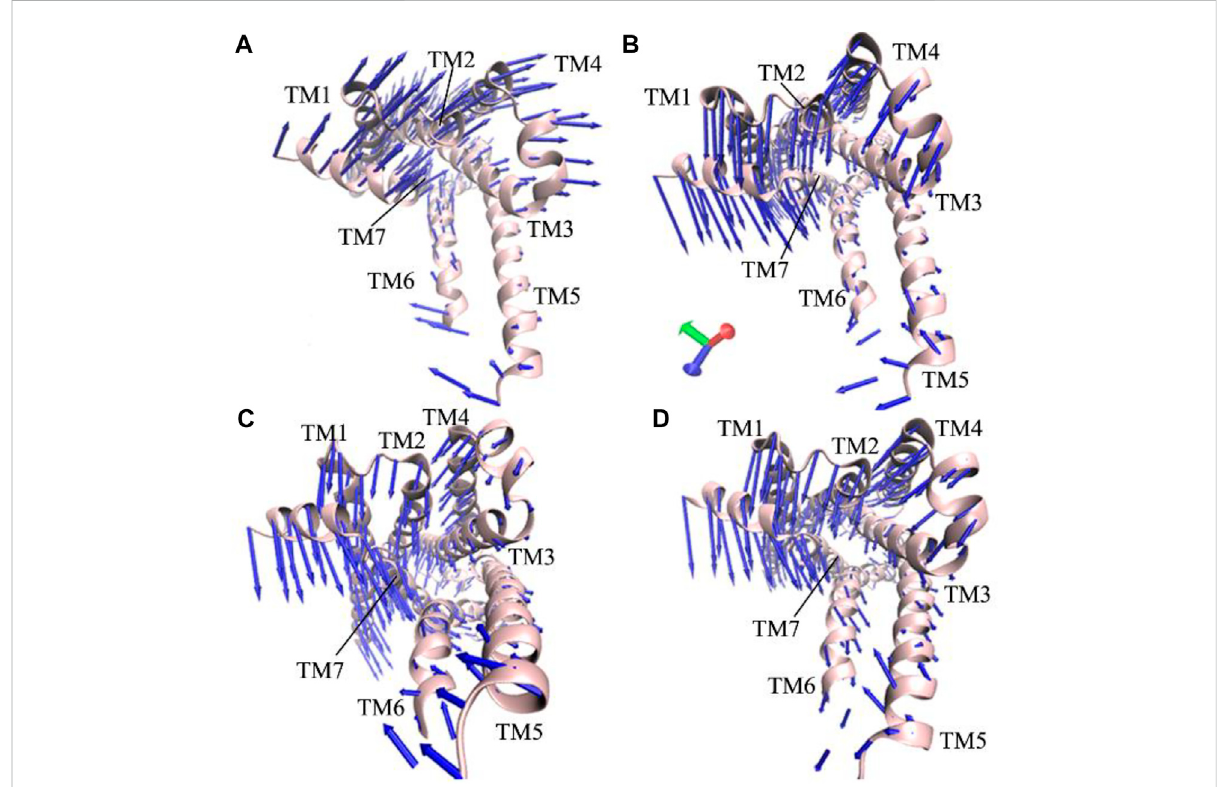
FIGURE 3 Concerted motions of structural domains from the β 2 AR: (A) the P0G-bound active β 2 AR with the Gs protein, and (B – D) corresponding to the P0G-, JTZ-, and JRZ-bound active β 2 AR without the Gs protein,